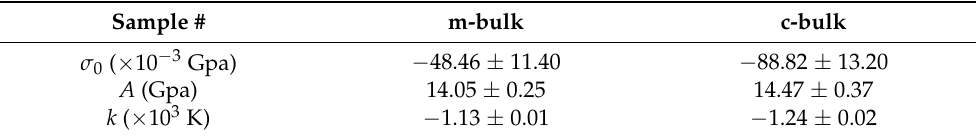
Figure 8. Relationships ( a , b ) between the biaxial stress and FWHM of E 2 (high) mode versus 1000/T for the m-bulk and c-bulk samples. Table 5. Fitting parameters σ 0 , A , and 1/ t for the relationship between E 2 (high) phonon biaxial stress and temperature of two bulk AlN samples by the first-order exponential growth function.